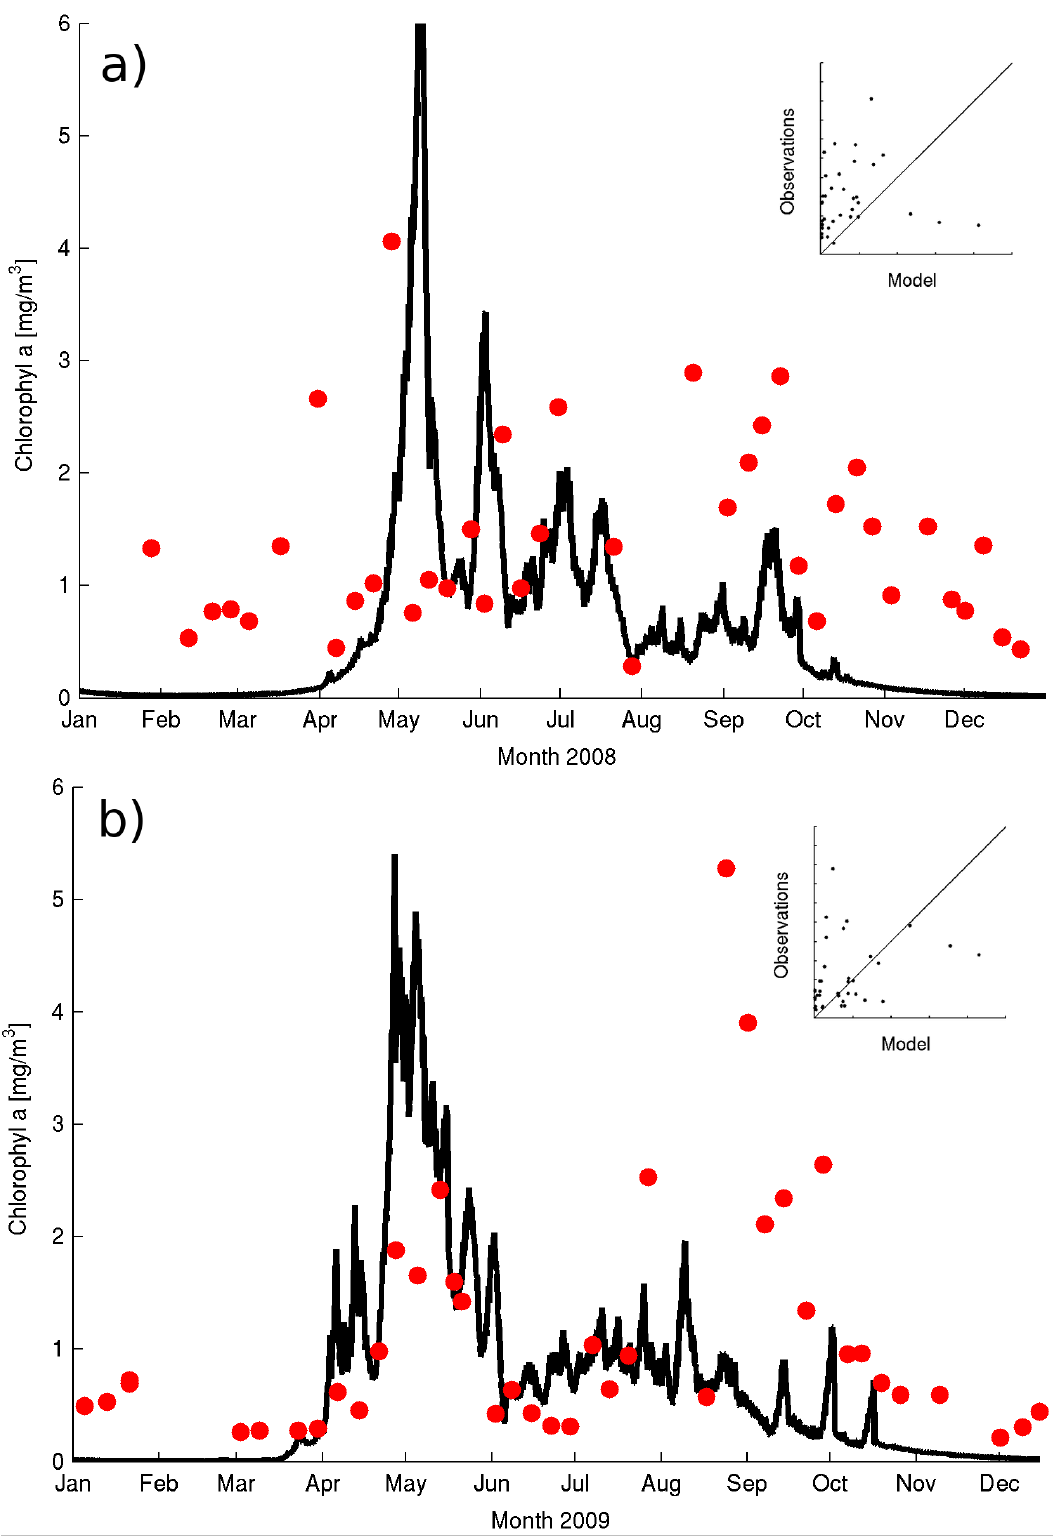
Figure 3. Surface evolution of total chl-a for ( a ) 2008 and ( b ) 2009. The observations correspond to the red dots while the model is the solid line. The one to one plot between observations and model results is included as a thumbnail to illustrate the correspondence between the